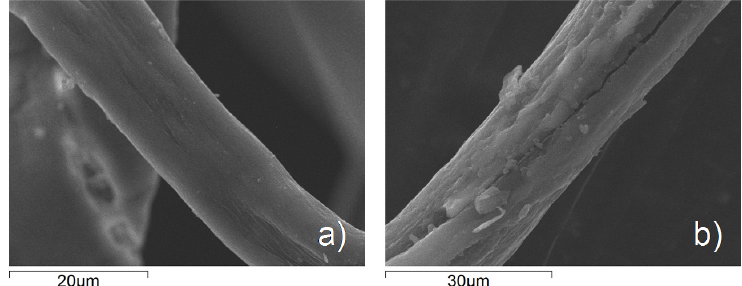
Figure 5. SEM micrographs of: ( a ) an uncoated fabric fiber and ( b ) a fabric fiber coated with the TACF nanosol.